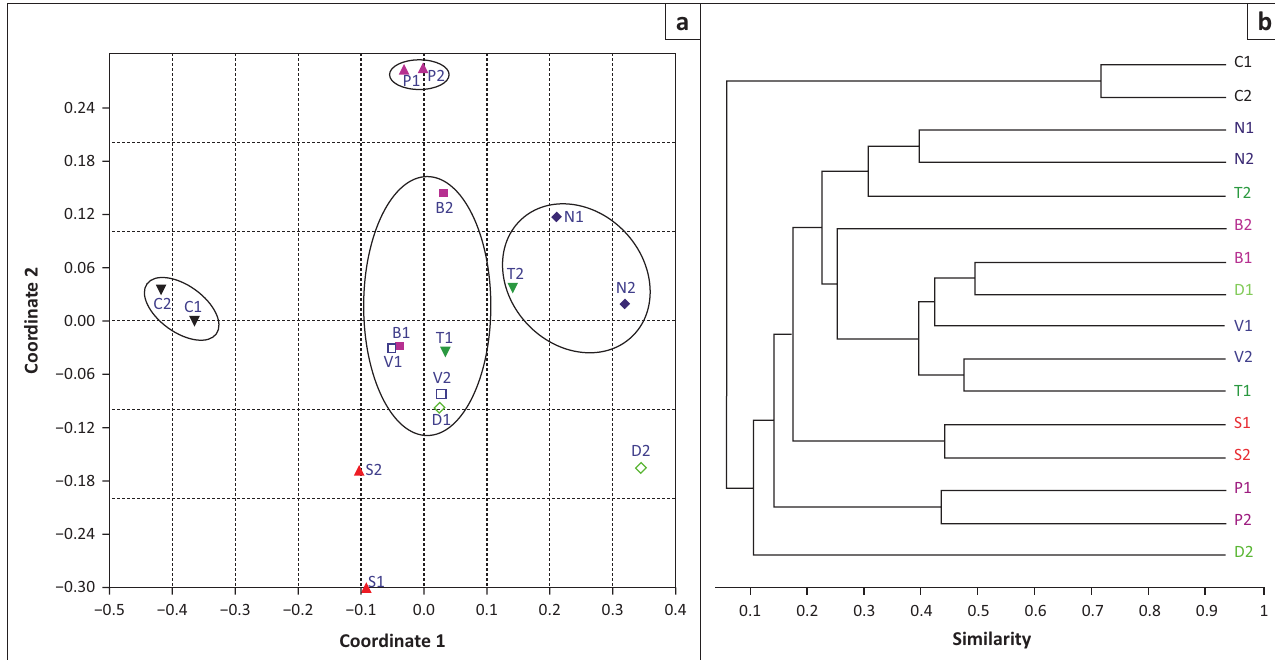
FIGURE 4: (a) Non-metric multidimensional scaling plot and (b) cluster analysis dendrogram using unweighted pair-group average algorithm of ground-dwelling spider assemblages sampled from eight habitats in the Amanzi Private Game Reserve. Analyses are based on a Bray–Curtis dissimilarity matrix using untransformed data. Habitat abbreviations: B, Searsia burchellii closed evergreen shrubland; C, cultivated Digitaria eriantha pastures; D, freshwater dam; N, Olea europaea closed evergreen shrubland on northern slopes of hill; P, O. europaea closed evergreen shrubland on plateau of hill; S, O. europaea closed evergreen shrubland on southern slope of hill; T, Tarchonanthus camphoratus closed evergreen shrubland; V, Vachellia karroo open deciduous shrubland.